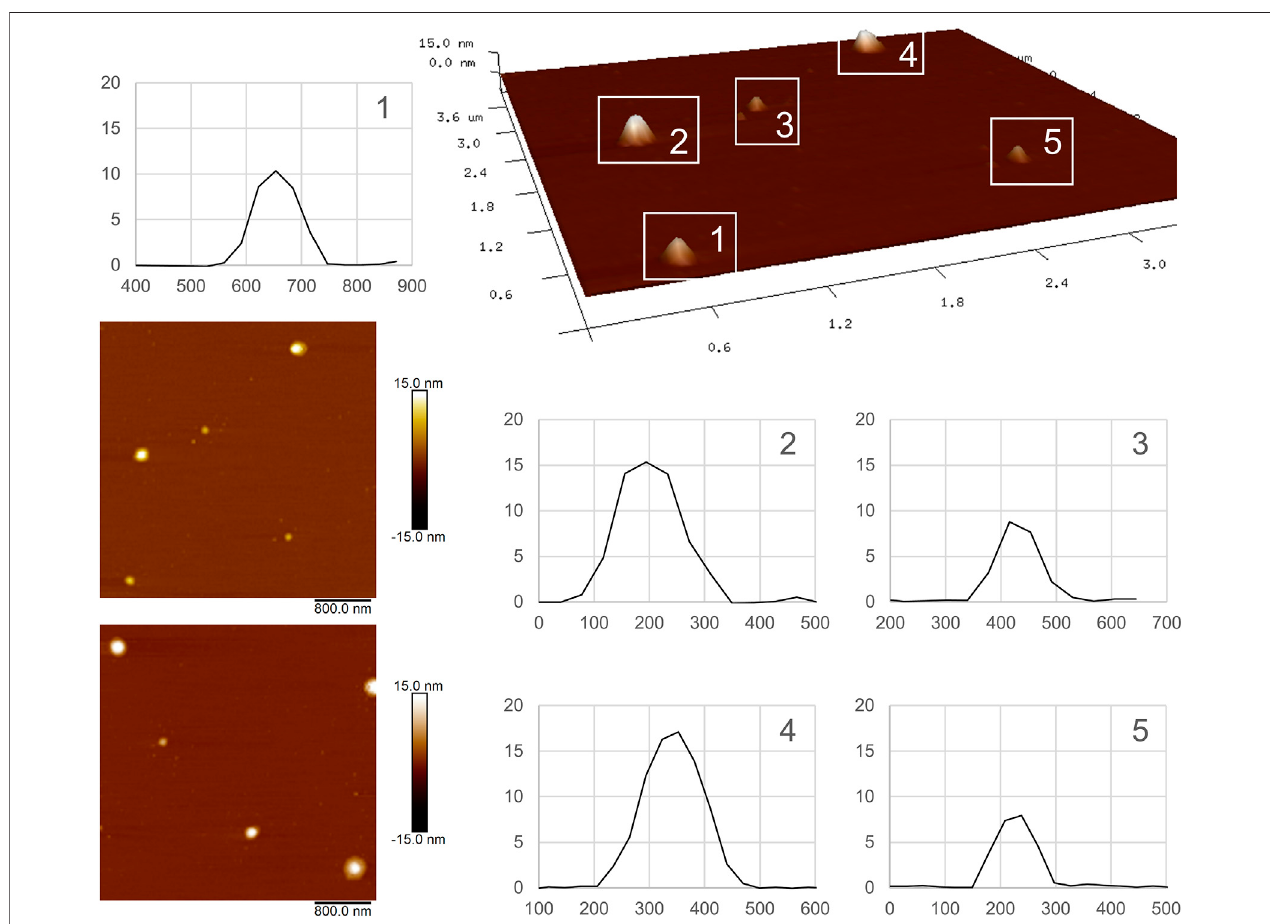
FIGURE 2 | AFM images of NLC-PB. On the left, two independent 2D images are presented. The 3D image corresponds to the upper one. In the size curves, the X -axishasanarbitraryorigin,and thusitservestomeasuredifferences(diameters).Attractiveforceswiththesupportandweakforces oftheprobegenerate fl atteningin the analyzed NPs resulting in smaller z particle